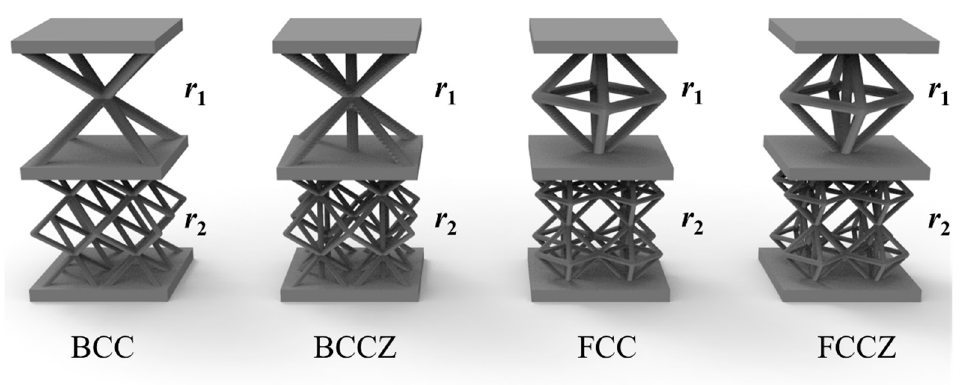
Figure 13. Structures of BCC, BCCZ, FCC and FCCZ lattice cells.